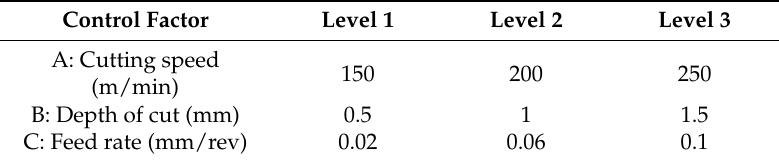
Table 7. Cutting